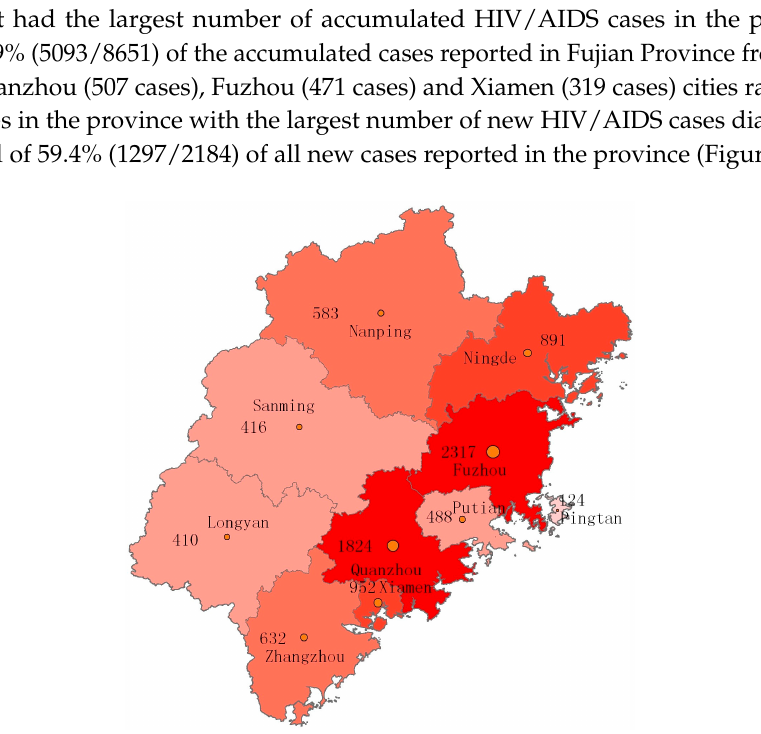
Figure 6. Geographic distribution of reported HIV/AIDS patients in Fujian Province from 1987 to 2015.